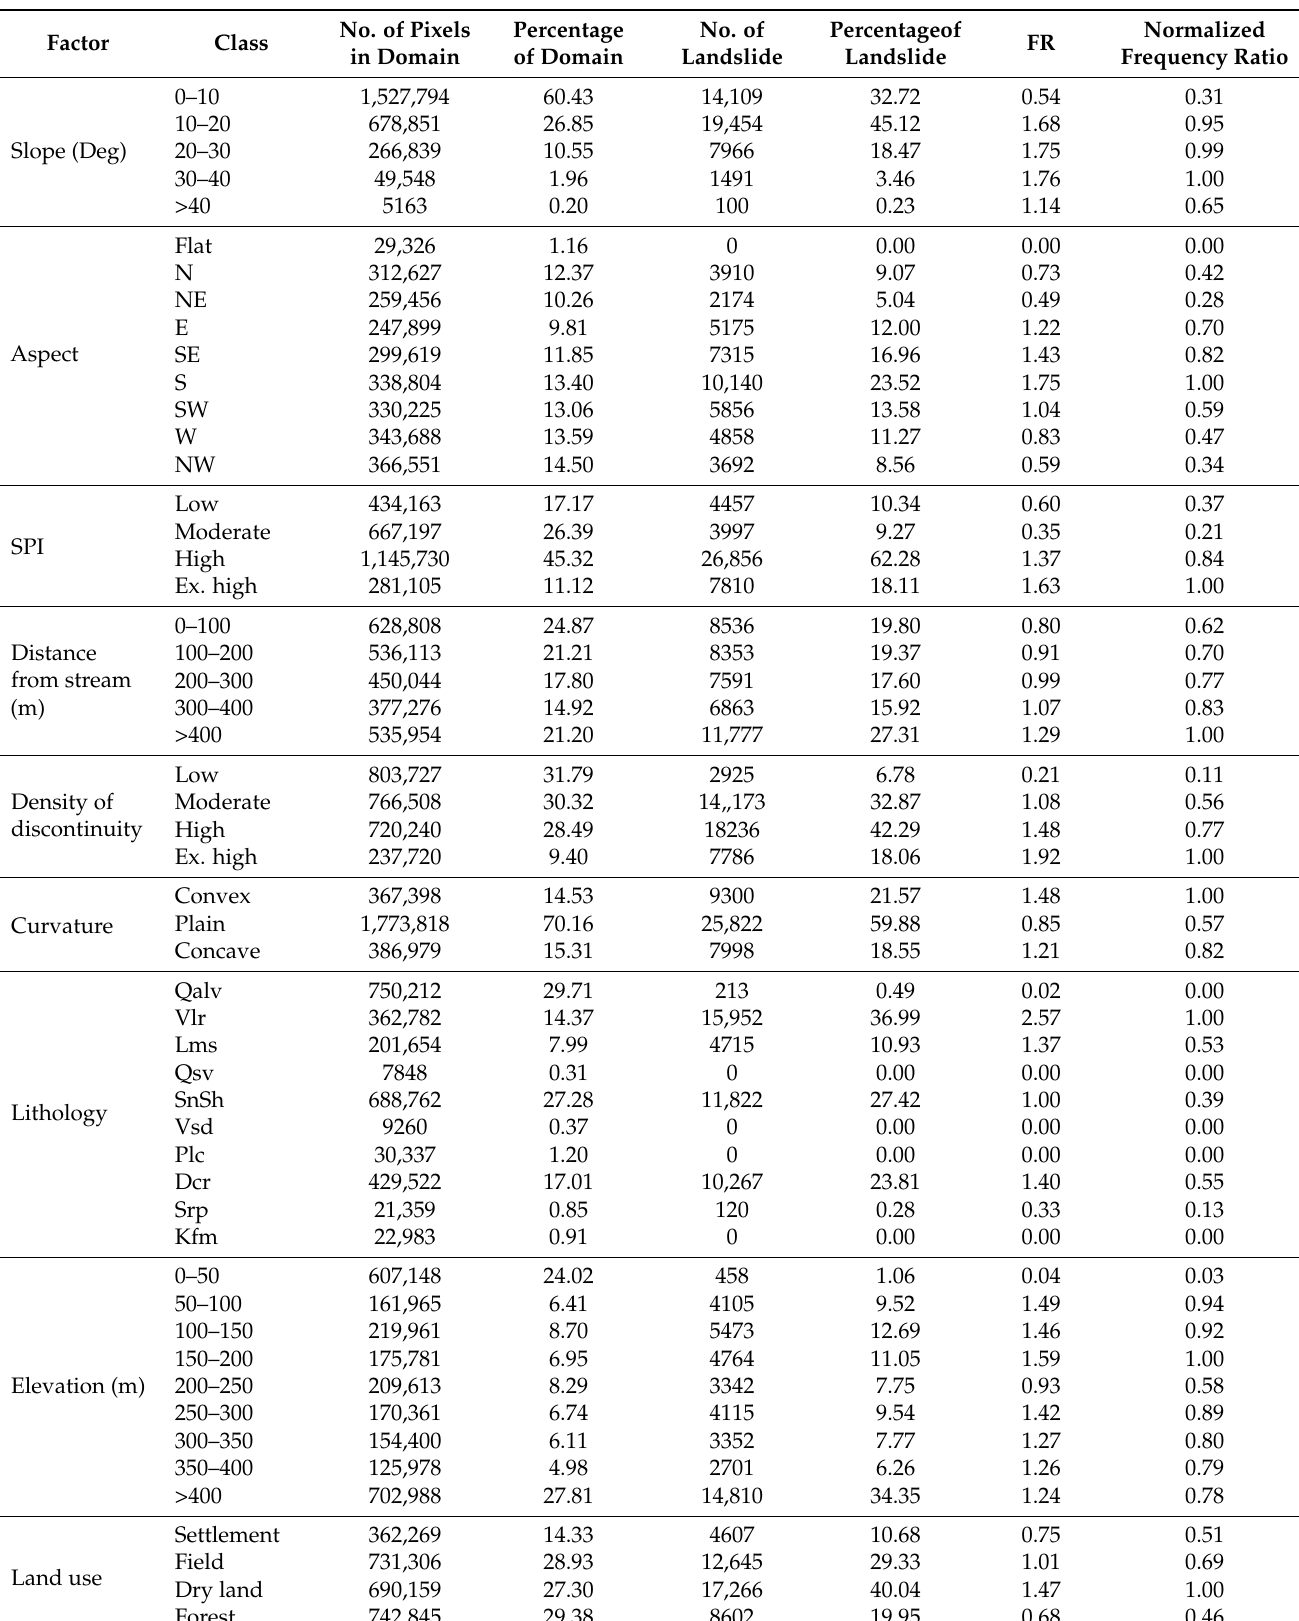
Table 5. FR values for causative